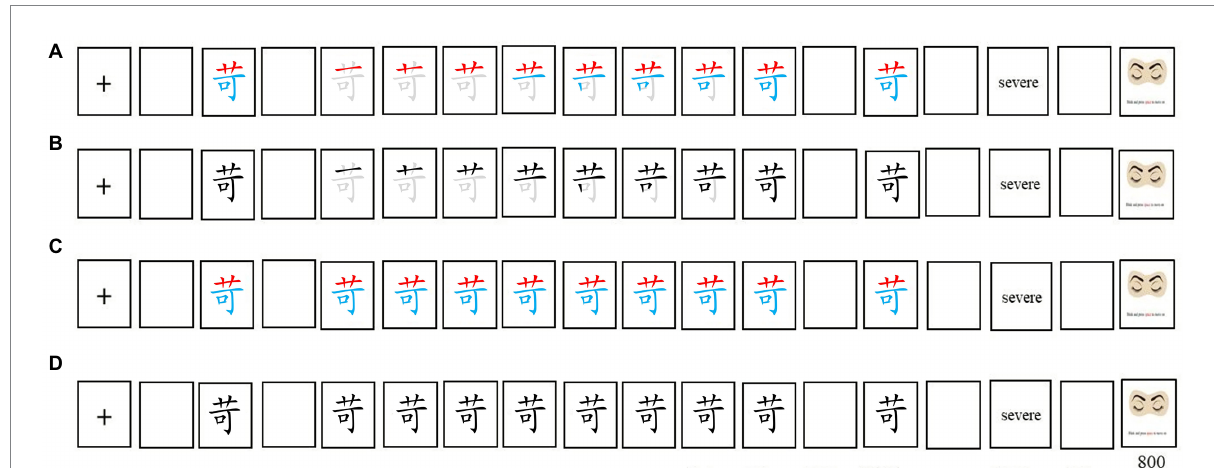
FIGURE 1 Provides an example of the four different presentation modes of the same character and the learning procedure. The four different presentation conditions are: (A) presented radical markings with stroke animations; (B) presented no radical markings with stroke animations; (C) presented radical markings without stroke animations; or (D) neither presented radical markings nor stroke